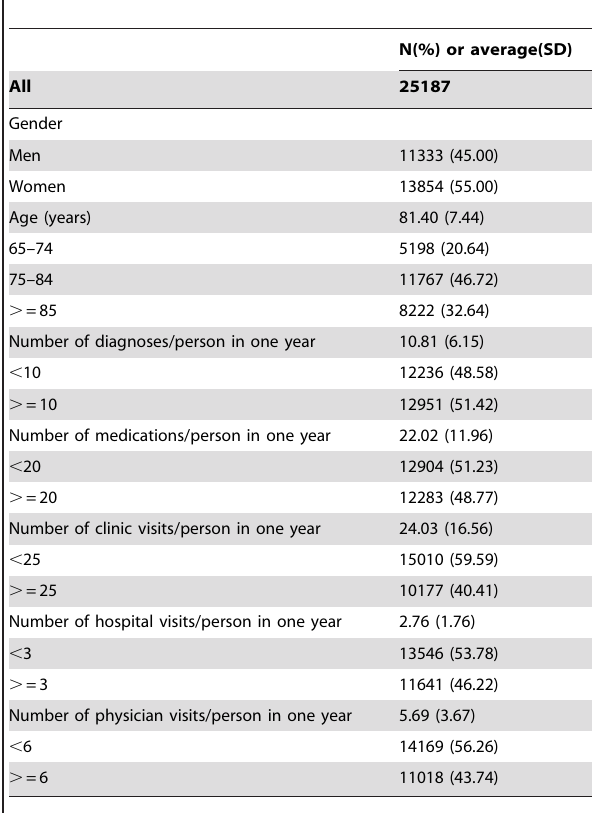
Table 1. Basic characteristics of the home healthcare